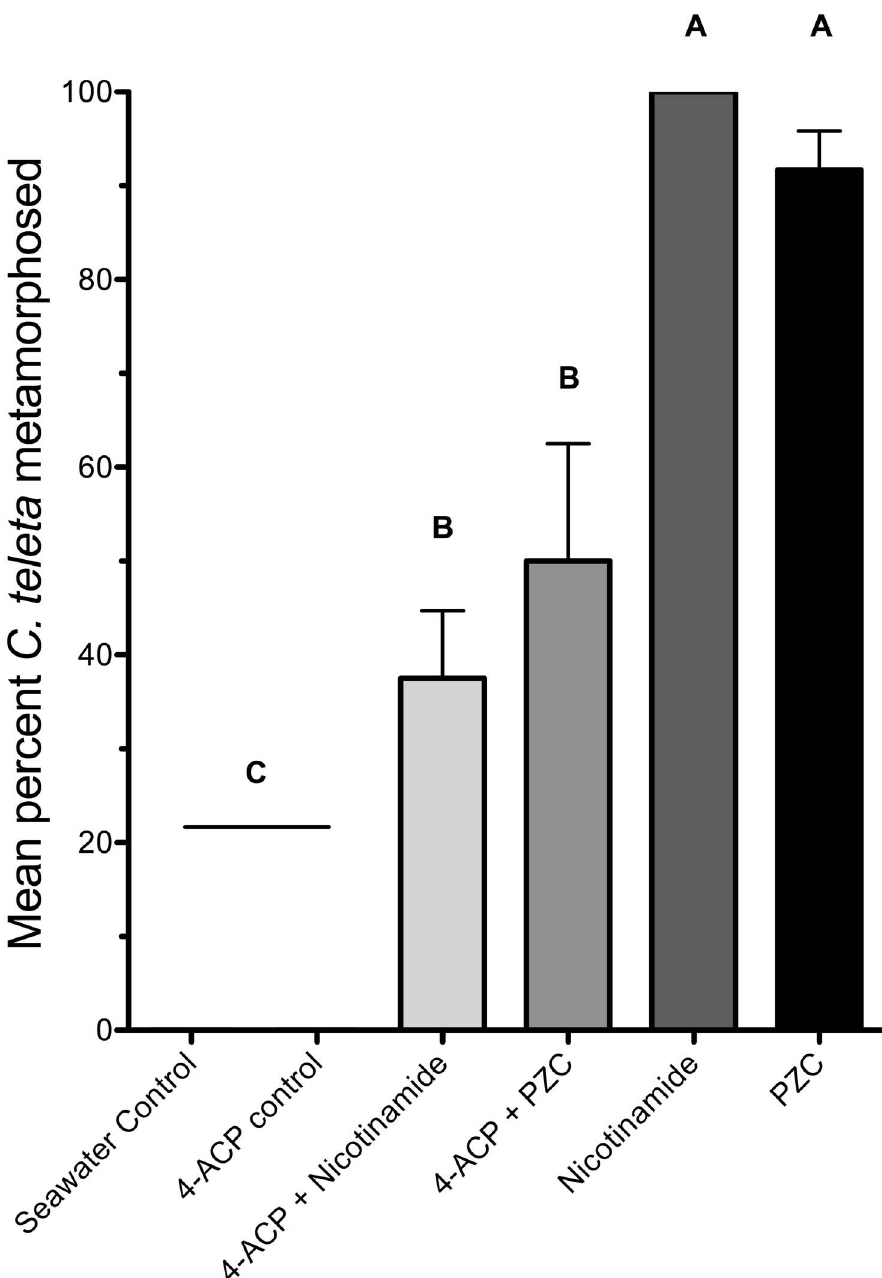
Figure 5. The effect of 4-acetylpyridine on metamorphosis of C.teleta in the presence of nicotinamide or pyrazinecarboxamide. Larvae were acclimated to 200 m M 4-acetylpyridine (4-ACP) for one hour before being transferred to a solution of 200 m M 4-acetylpyridine and either nicotinamide or pyrazinecarboxamide (PZC) at 40 m M for 24 h. Each treatment consisted of 3 replicates with 8 larvae per replicate. Artificial seawater (Instant Ocean) acted as a negative control. Letters indicate significant (P , 0.05) differences as determined by a Bonferroni post-hoc test. Error bars represent + s.e.m.